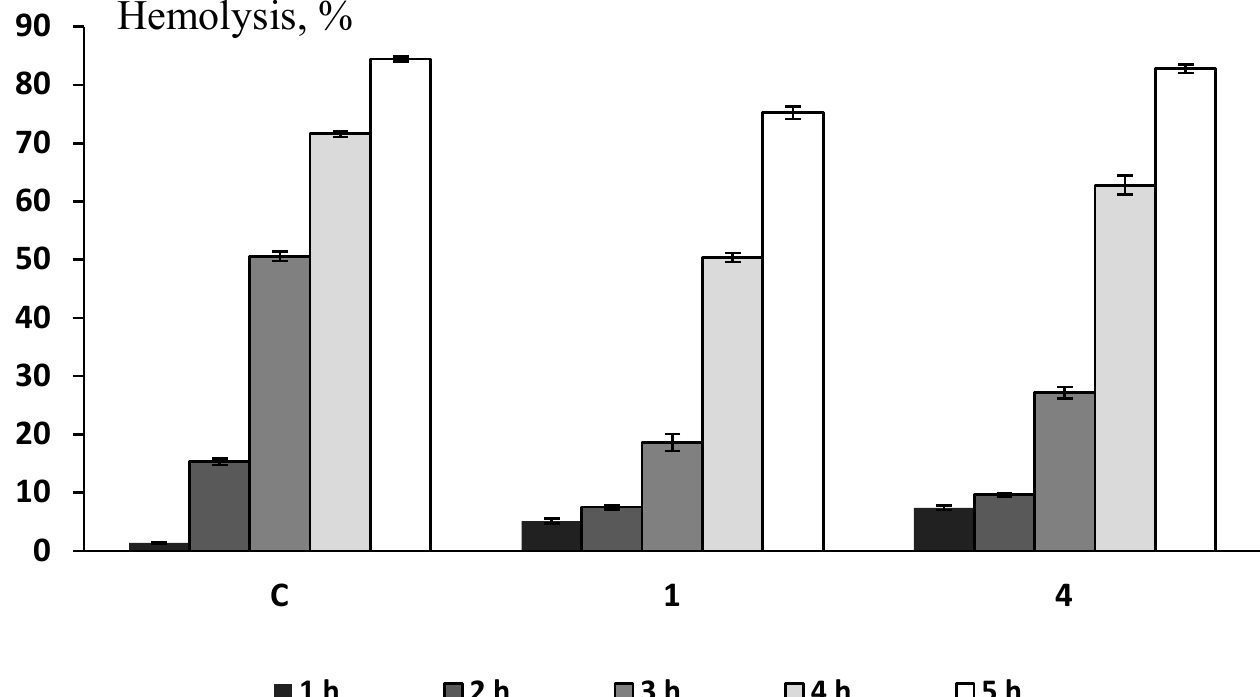
Figure 7. The influence of compounds 1 and 4 (100 µM) on the level of AAPH-induced erythrocyte hemolysis after 1–5 h of incubation. Vertical bars: means ± SE ( n = 3–6). Table 1. The influence of compounds 1–6 (100 µM) on the parameters of H 2 O 2 and AAPH-induced hemolysis of red blood cells. * p ≤ 0.05, ** p ≤ 0.001–in comparison with the control. Experiment 1 ( Н 2 О 2 -induced hemolysis) Control